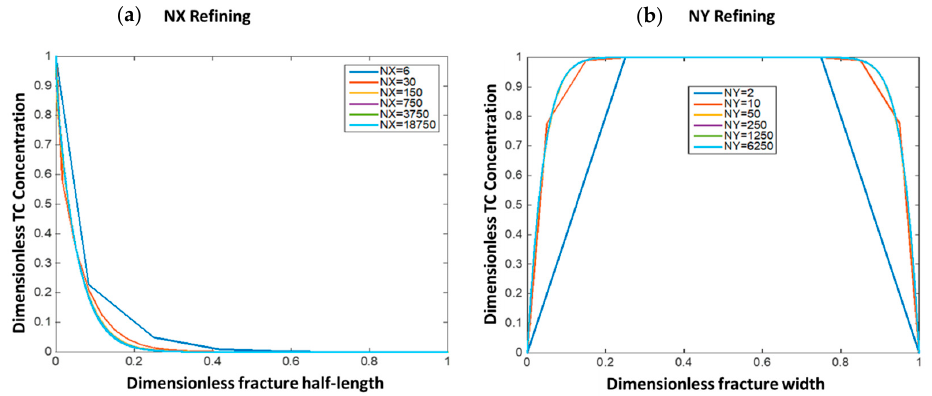
Figure 6. The impact of grid refining on solution convergence for both ( a ) x-direction and ( b ) y-direction.